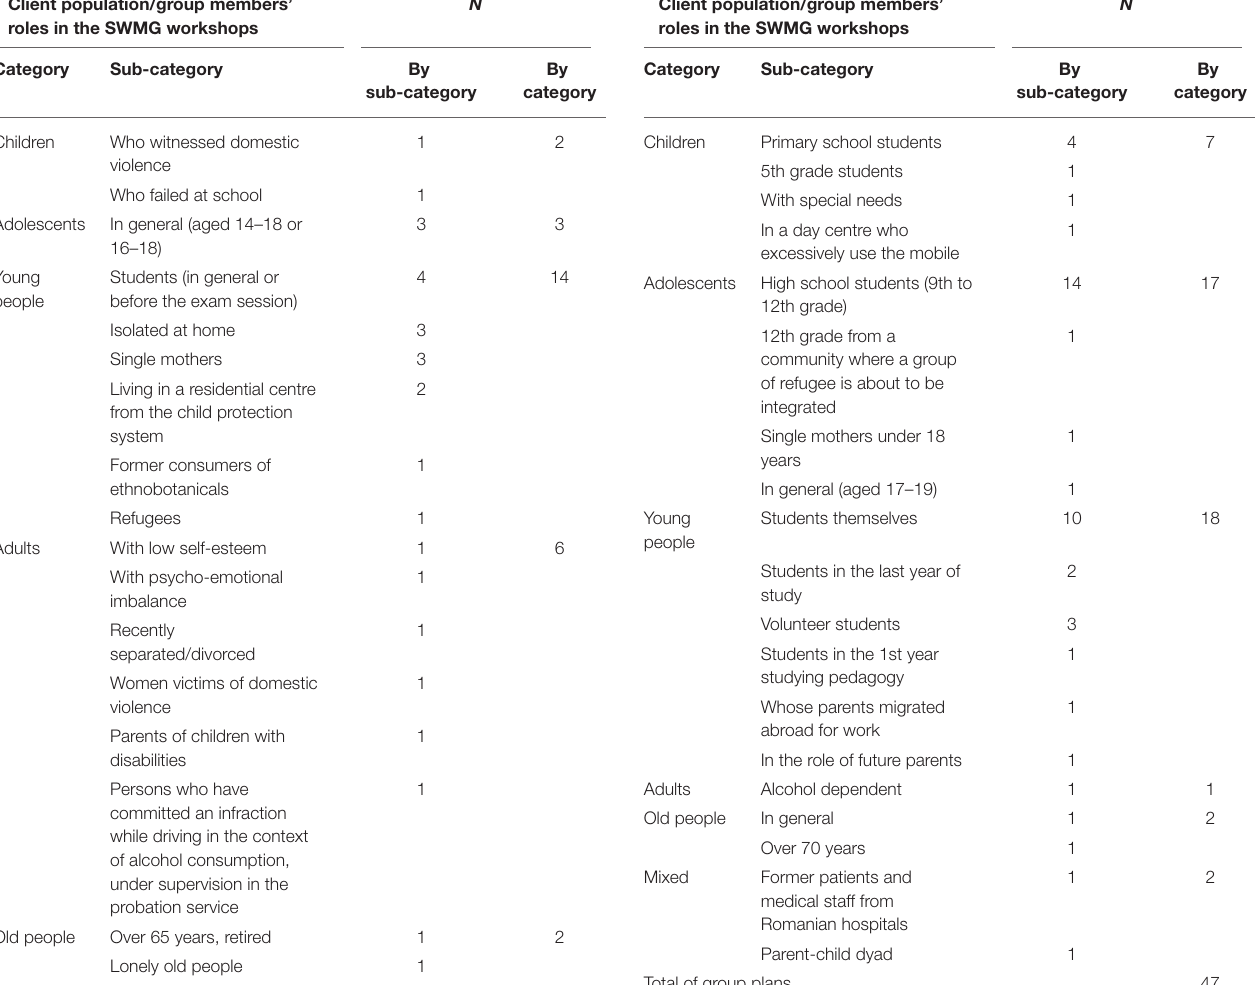
TABLE 6A | The client population the co-leaders addressed in their social work methods with groups (SWMG) workshops in 2020 cohort A. Client population/group members’ roles in the SWMG workshops